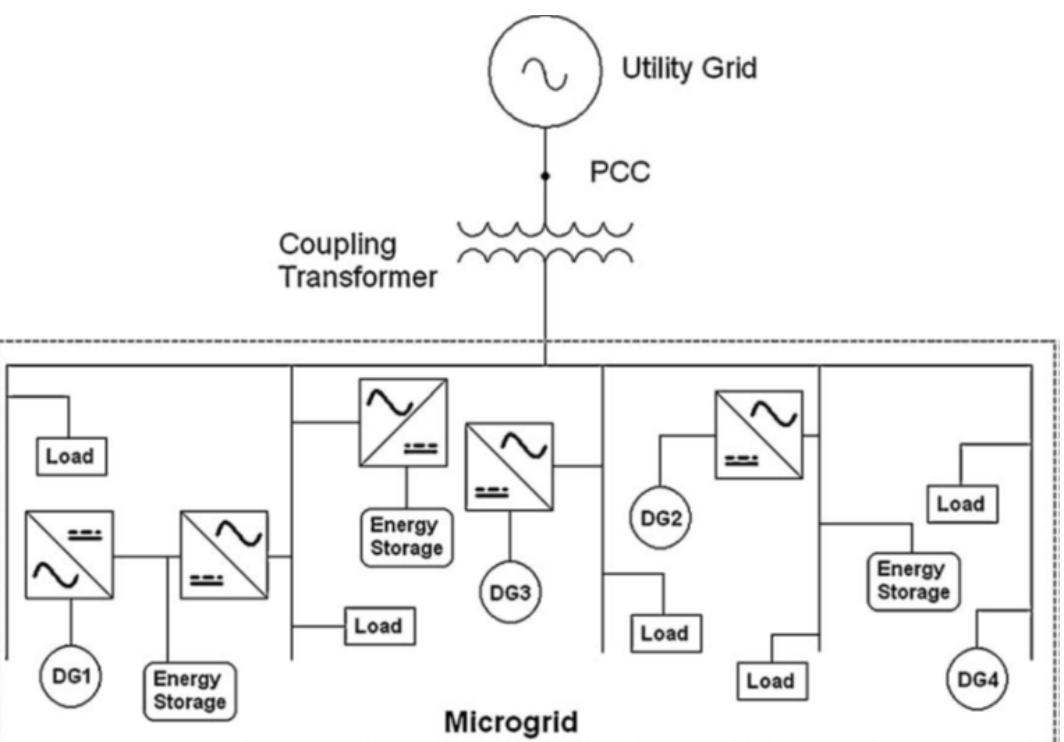
Figure 3. A typical architecture of a